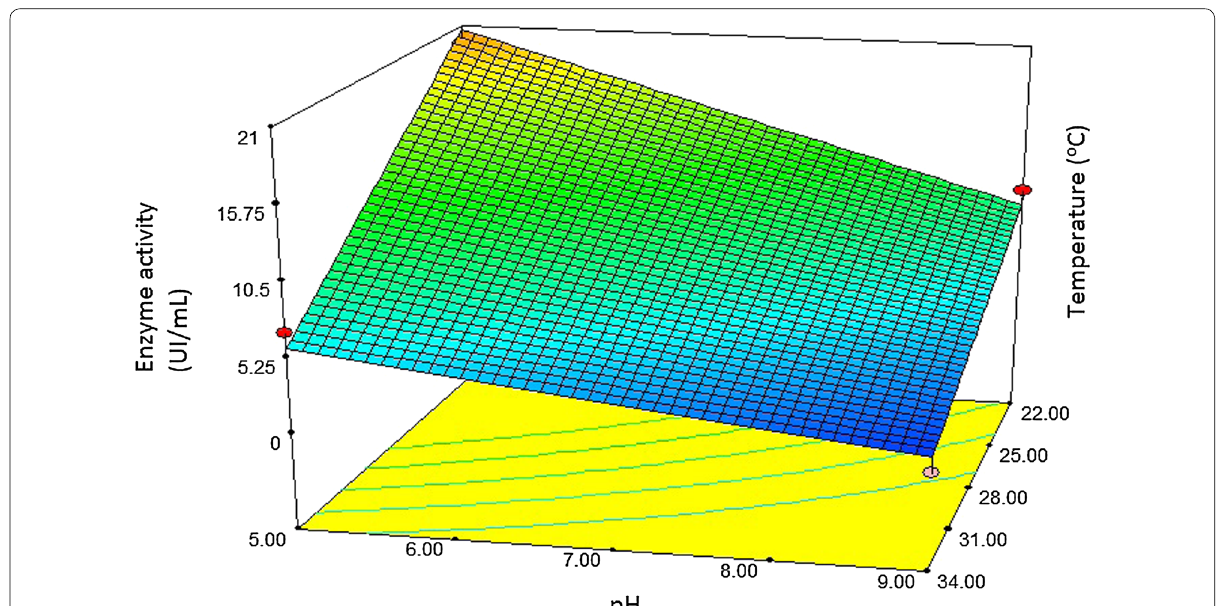
Fig. 2 Response surface curve of β‑galactosidase activity affected by temperature and pH using the 2‑factor central composite design